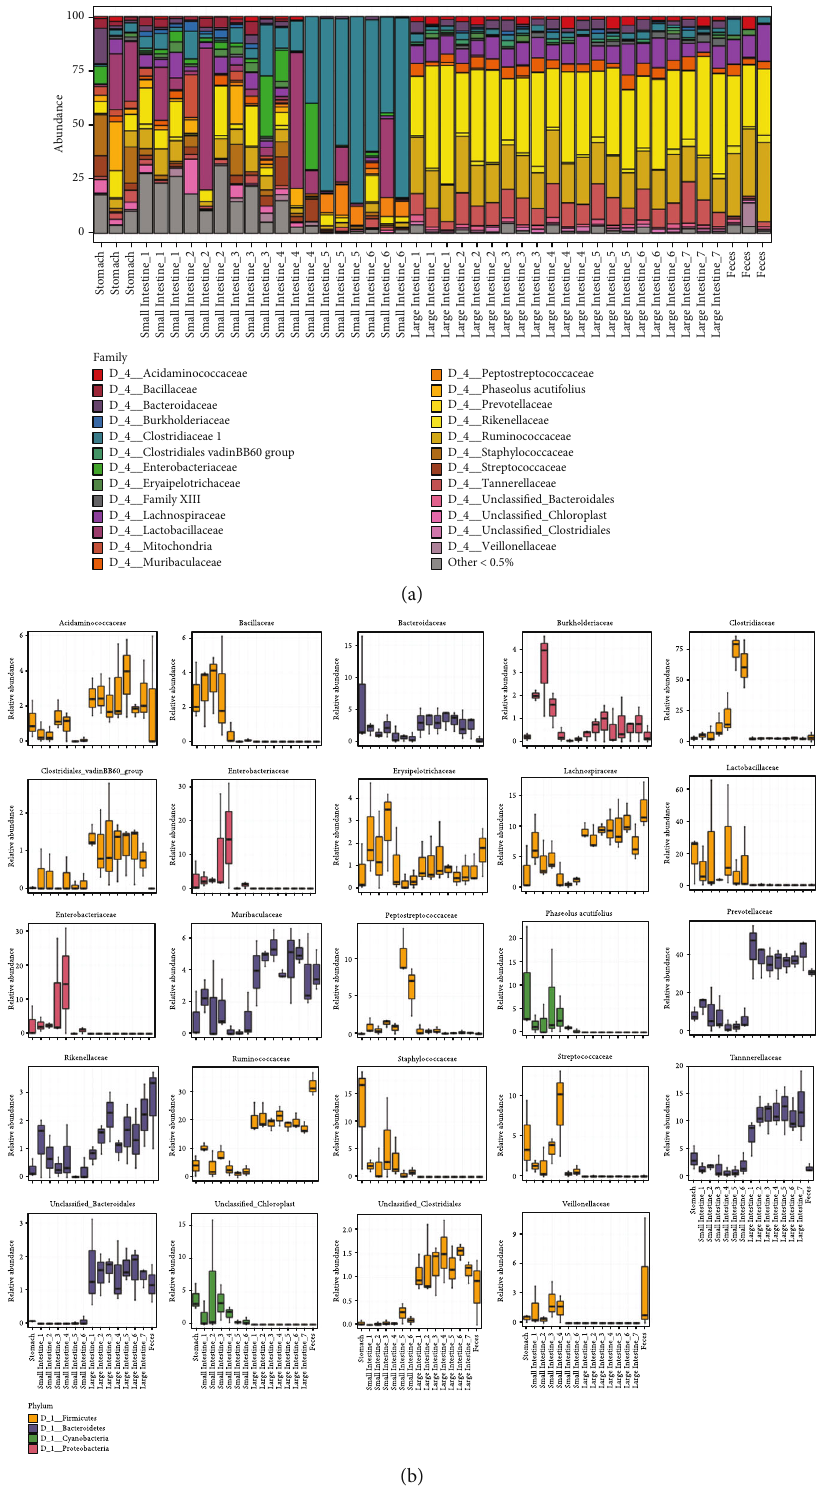
Figure 3: Relative abundances of sequences belonging to di ff erent families in the GI tracts. (a) The relative abundance of families at 14 locations of GI tract and feces. (b) The boxplots of the most abundant families for all through samples. Plot color represents the phylum level of families. The sampling locations within the GI tract were determined based on the anatomical feature: the stomach, the duodenum (small intestine_1), the jejunum (small intestine_2 ~ small intestine_5), the ileum (small intestine_6), the cecum (large intestine_1), the colon (large intestine_2 ~ large intestine_6), and the rectum (large intestine_7). The anatomical di ff erences between each location are shown in Figure